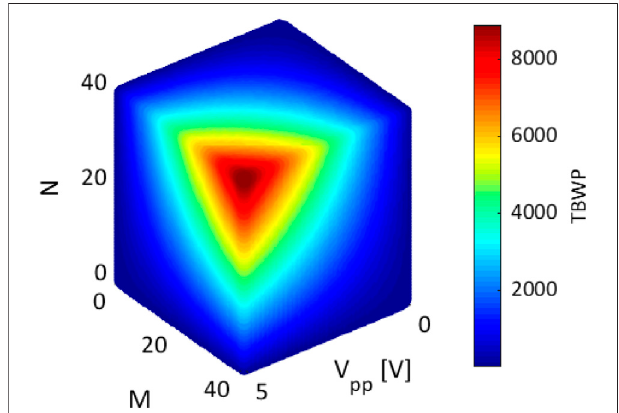
FIGURE 2 | TBWP vs. V pp , N, and M